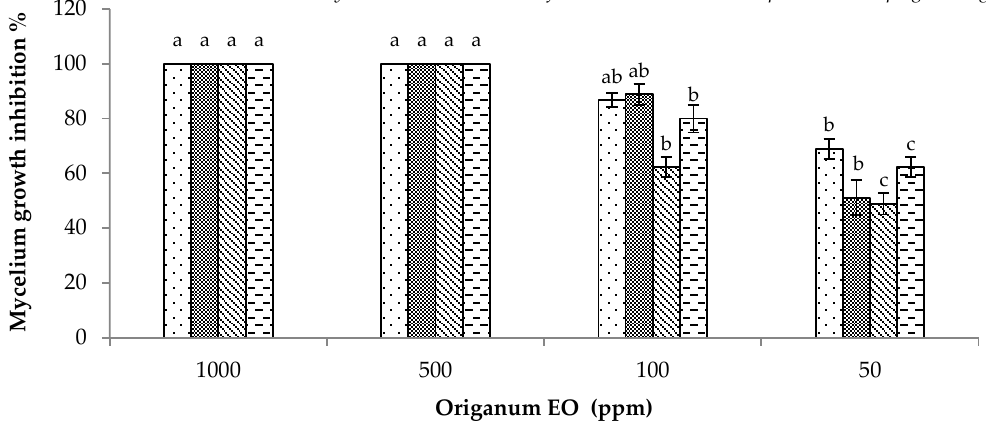
Figure 3. Antifungal activity of Origanum vulgare EO. Bars with different letters for each tested fungus indicate mean values significantly different at p < 0.05 according to Tukey B test. Data are expressed as mean of three replicates ± SD.